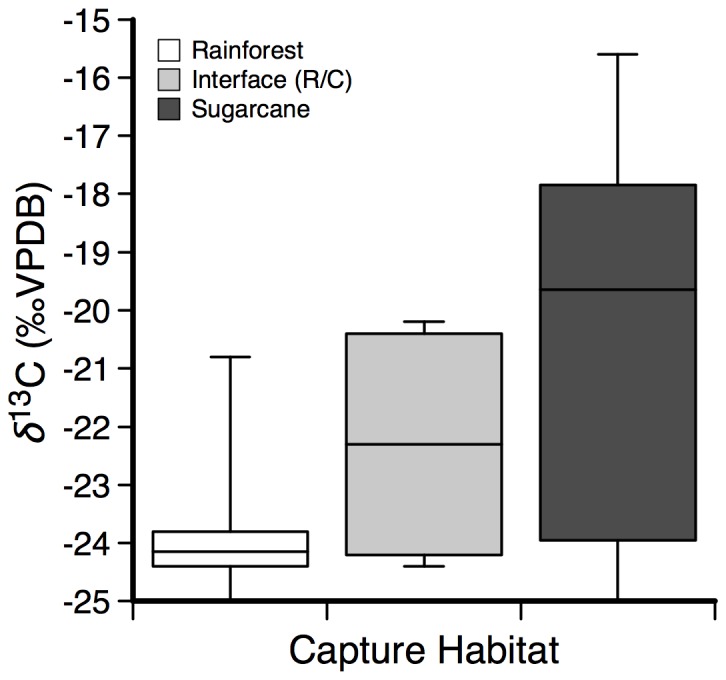
Box and whisker plot showing mean δ13C values of base hair.